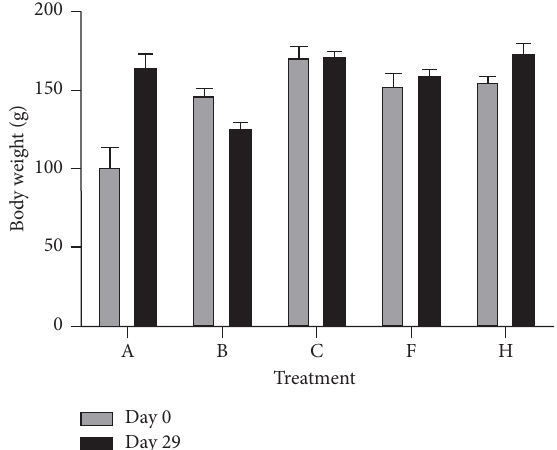
Figure 1: Efect of the K. senegalensis and A. indica hydroethanolic extracts on body weights of the diabetic rats. Results expressed as mean ± SD, n � 3 (with 95% confdence interval); A: normal con- trol; B: diabetic control; C: glibenclamide; F: K. senegalensis ; H: A. indica . Test period: 28days.